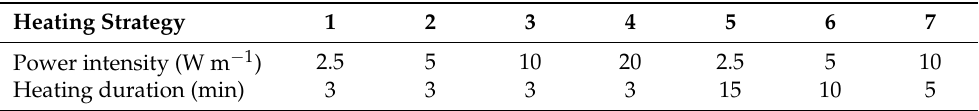
Table 2. Seven heating strategies and their power intensities and heating